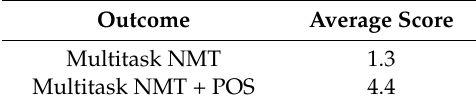
Table 5. Human evaluation scores—Pilot rating experiment for MA-MSA.